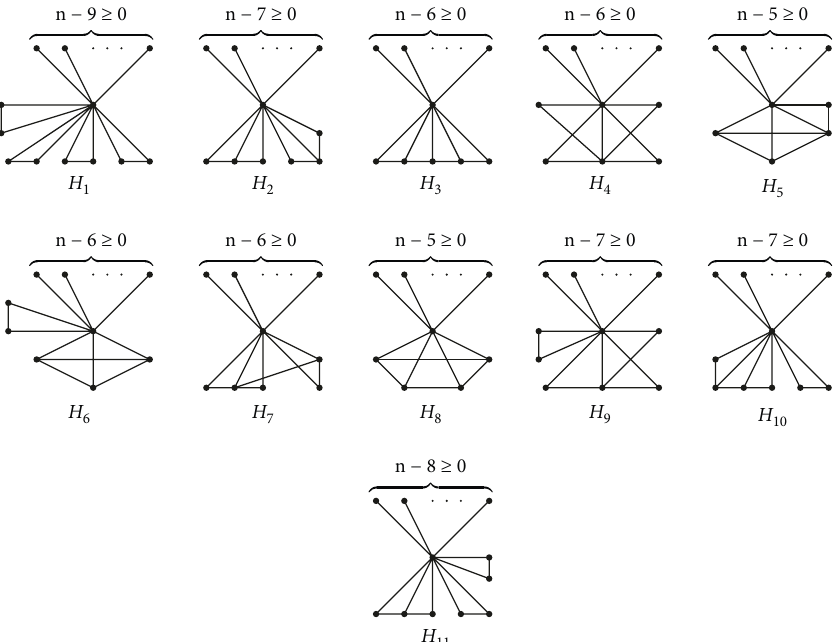
Figure 2: All possible tetracyclic graphs of order n and maximum degree n − 1.